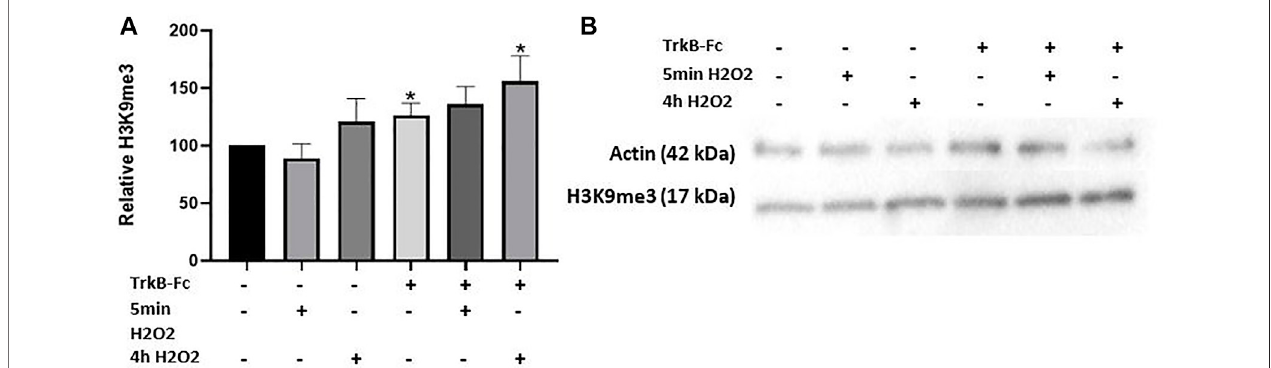
FIGURE 2 | TrkB-Fc and 4h H2O2 Signi fi cantly Elevate H3K9me3 in 12 DIV Neuron Cultures. (A) H3K9me3 western blot analysis of 12 DIV hippocampal neuron culturesthreated with200 μ MH2O2 for5 min8 hbeforeharvest or4 h,1 μ g/mlTrkB-Fcfor24 h.Welch ’ sANOVA, p =0.033, n =9forcontrol,TrkB-Fc,4 hH2O2and